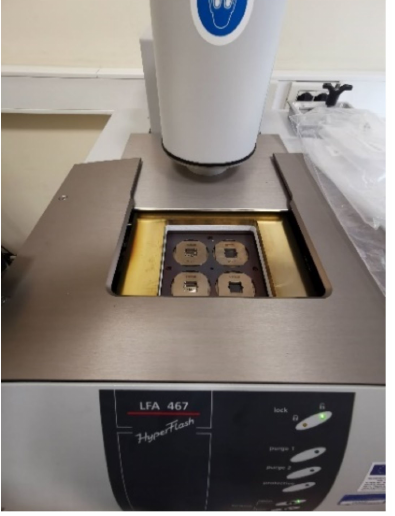
Figure 1. Thermal conductivity test setup on green